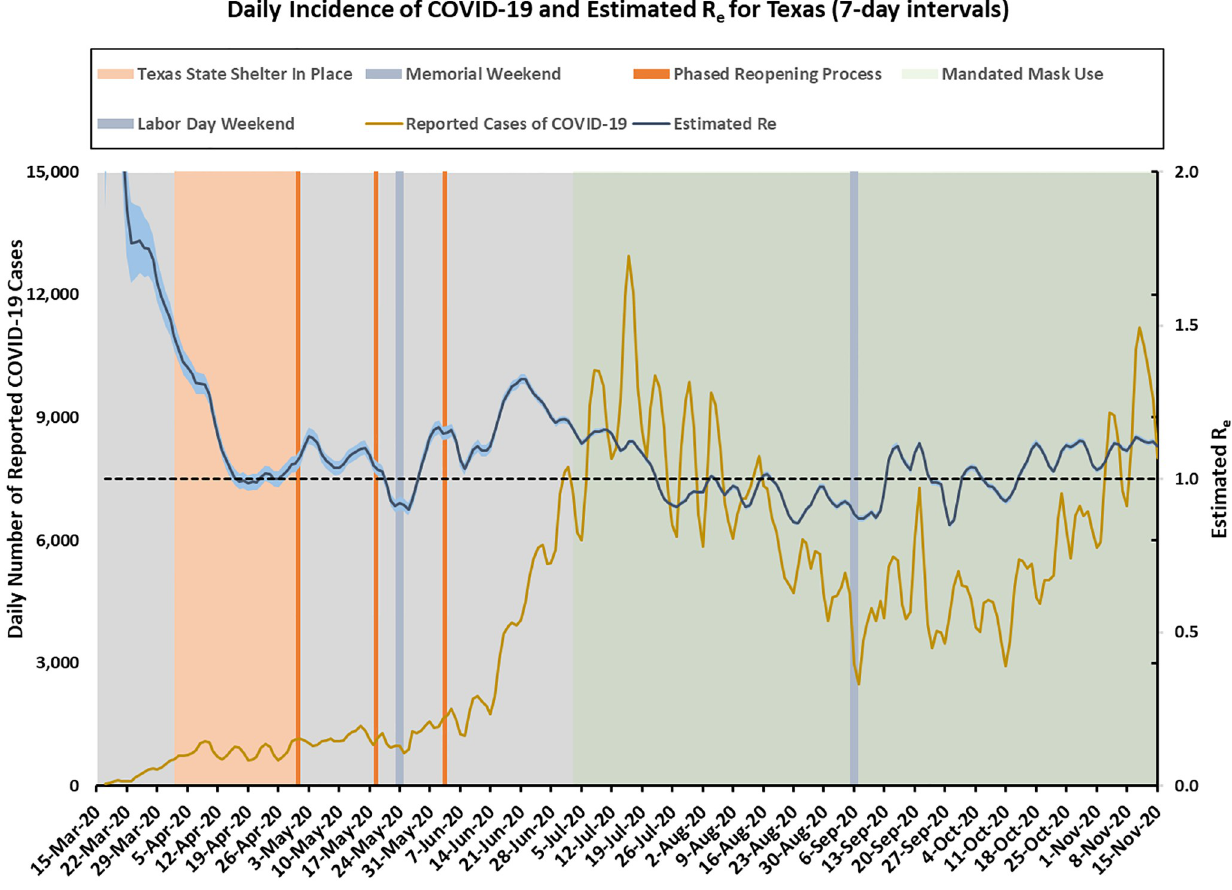
Fig 1. Texas incidence cases over time (smoothed) and the estimated effective reproduction number R e ( t ) (95% CI in shaded area) using 7-day